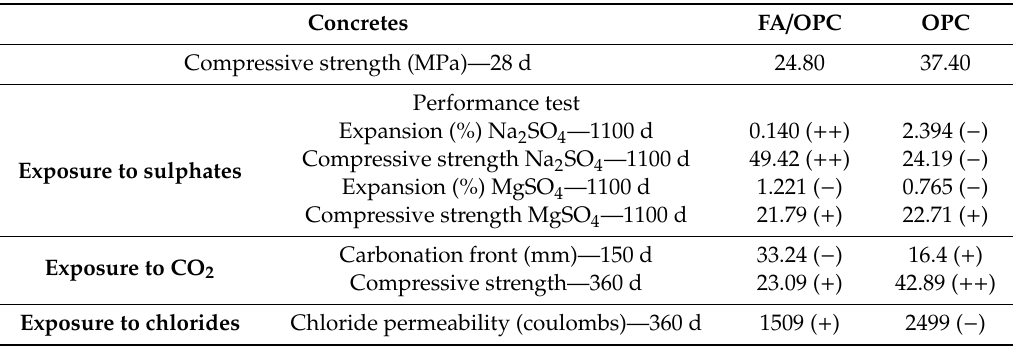
Table 3. Concretes